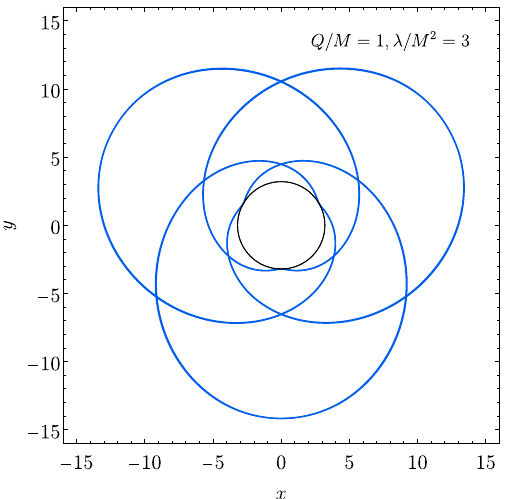
Fig. 30 Same as Fig. 26 for parameters Q / M = 1 . 6, λ/ M 2 = 30 . 4